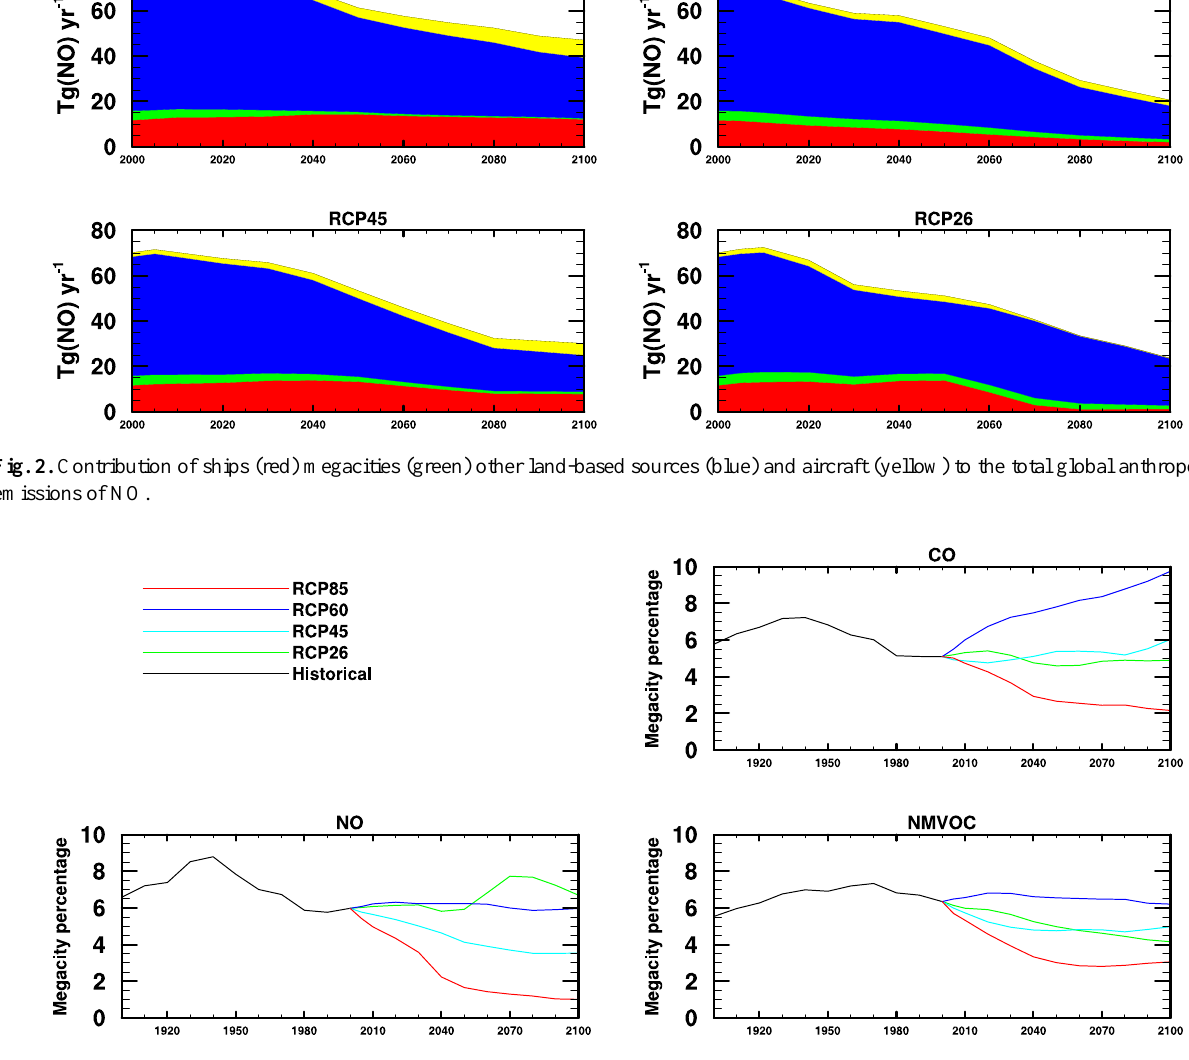
Fig. 3. Percentage of anthropogenic emissions due to